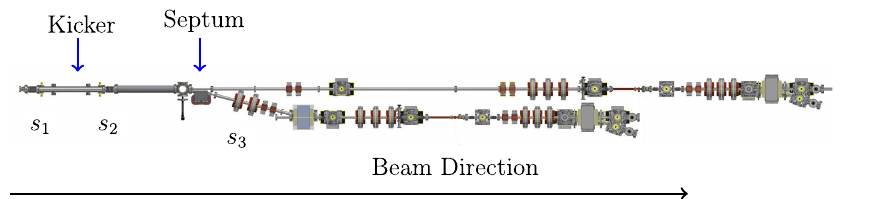
FIG. 6. Continuation of the high charge beam line layout at the AWA, top view. This is the proposed two beam acceleration section. Only the kicker in this drawing is installed. Note s 3 , the entrance to the fifth quadrupole on the beam line. This is the optimization